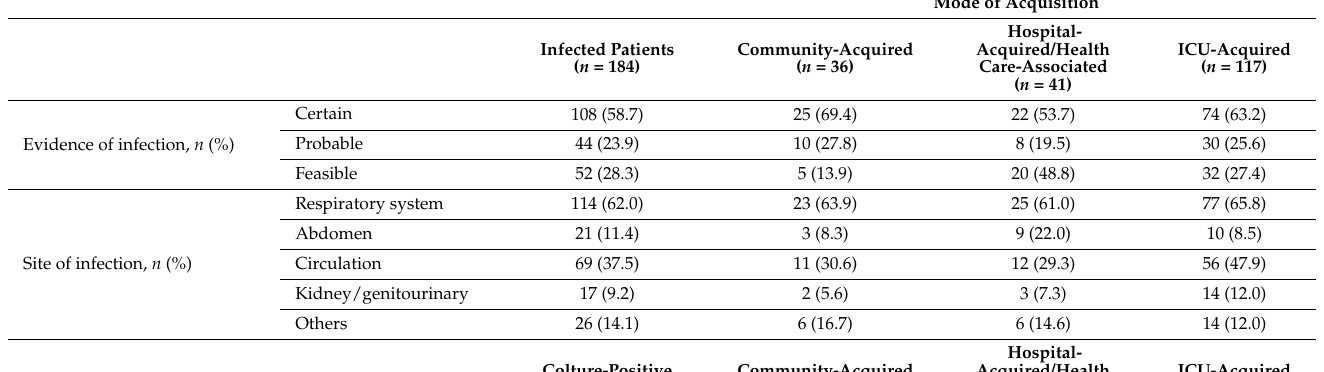
Table 2. Infection characteristics according to mode of acquisition and microbiological isolates (note: 184 infected patients, 114 culture-positive patients). Mode of Acquisition Infected Patients ( n =